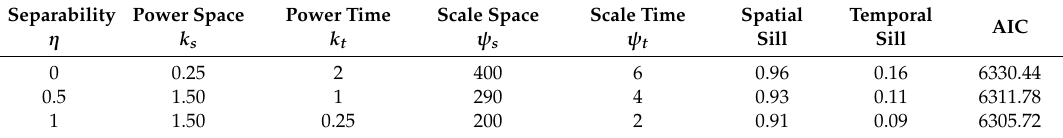
Table 4. Fitted parameters and Akaike information criterion reported for three modeled